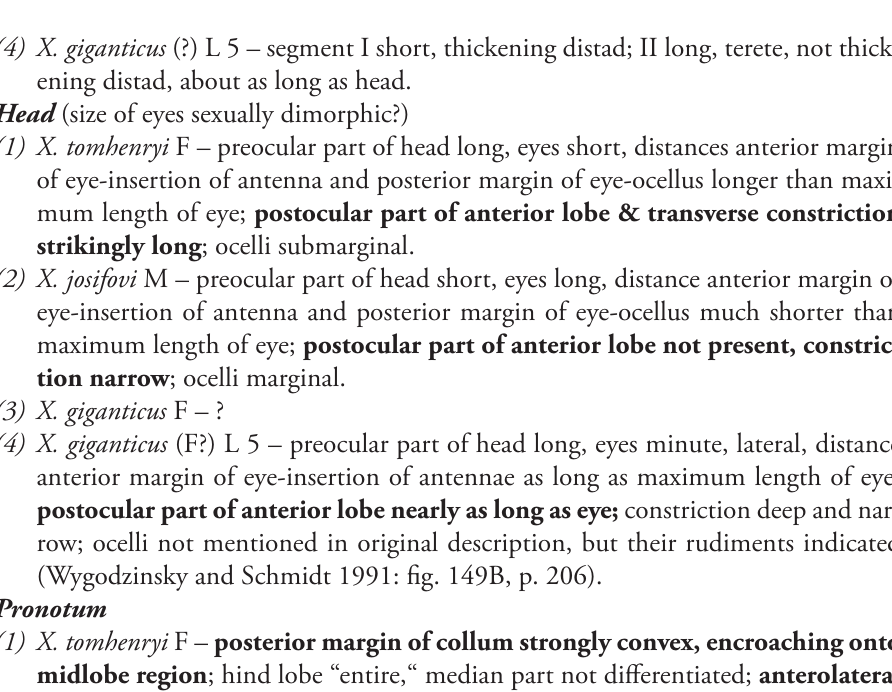
Figure 6. Xenicocephalus tomhenryi sp. n., female holotype, left foreleg, schemes, not measured. A apiciti- bial armature, antero-ventral view B apicitibial armature, ventral view C tarsal armature, ventral view, other macrotrichia